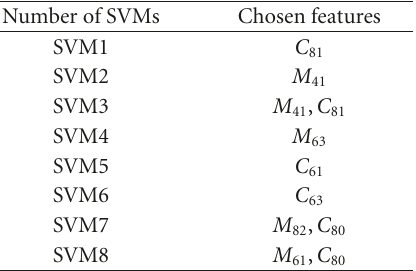
Table 2: Chosen features for each SVM. Number of